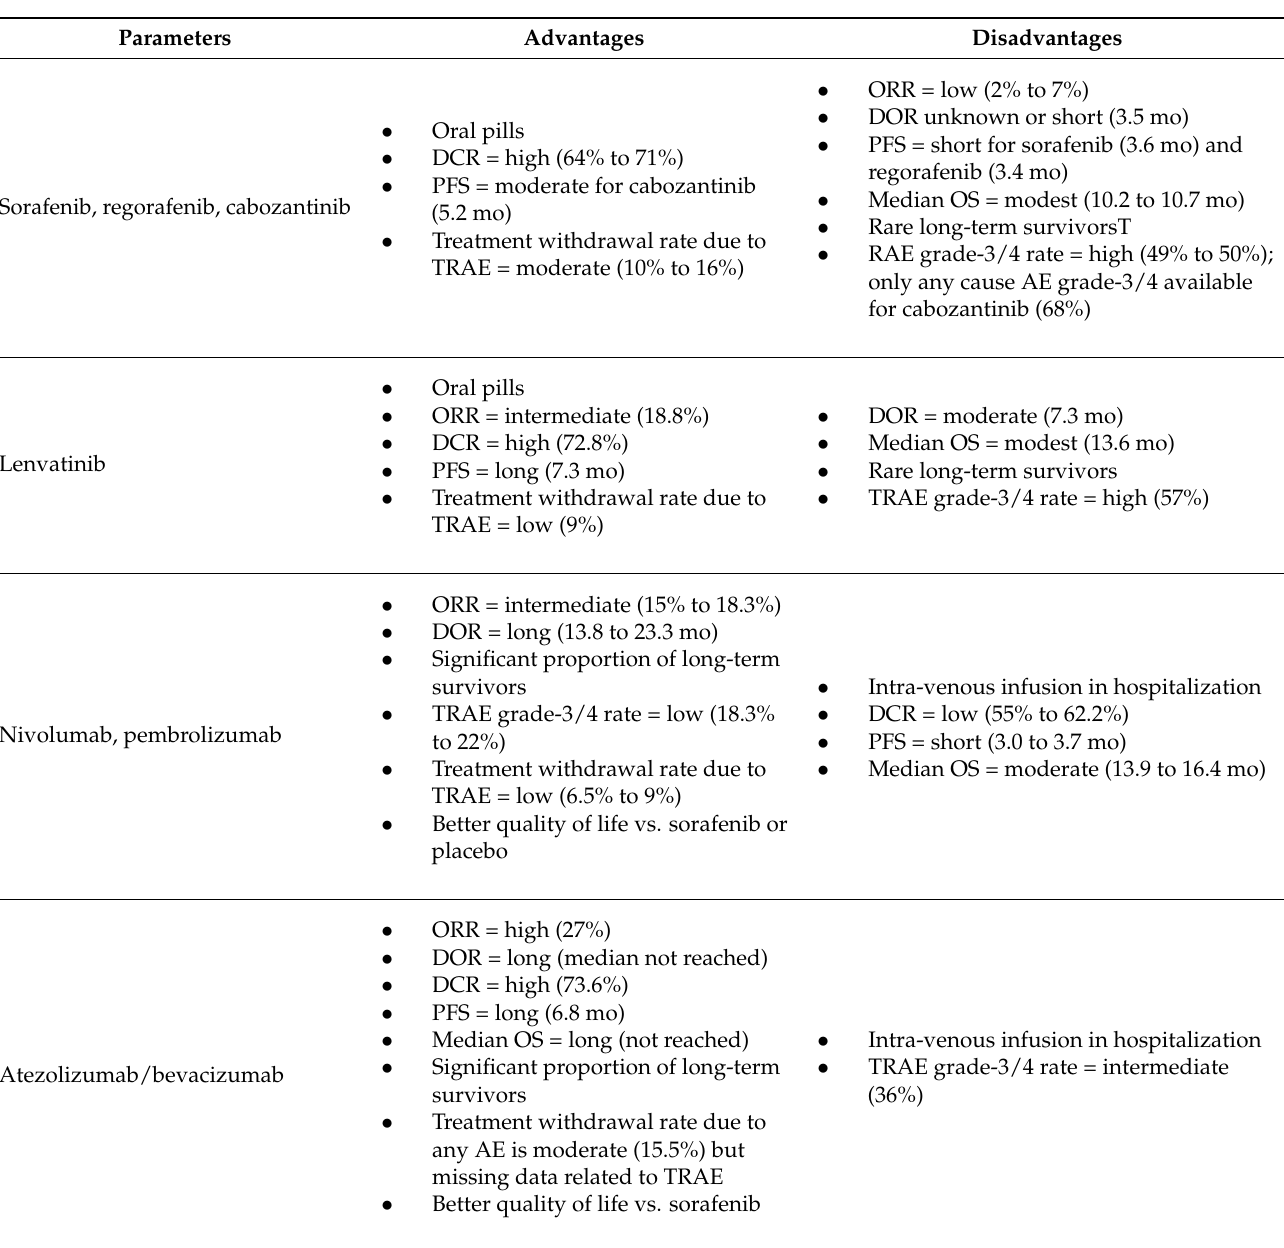
Table 4. Comparisons of tyrosine kinase inhibitor (TKI) or immune checkpoint inhibitors (ICI) monotherapies, and immuno- oncology-based combinations from phase-3 (SHARP [5], RESORCE [14], CELESTIAL [15], REFLECT [13], CheckMate-459 [20], Keynote-240 [21], IMbrave-150 [23]), or phase-1/2 with near coming phase-3 studies (STUDY-116 [30], CheckMate-040 [28], STUDY-22